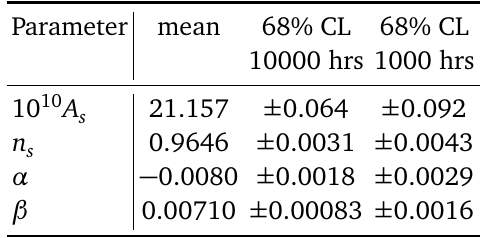
Table 4: Best fit parameter values and error bars for SKA likelihoods constructed as in 4 for primordial spectrum computation with spectral index and its